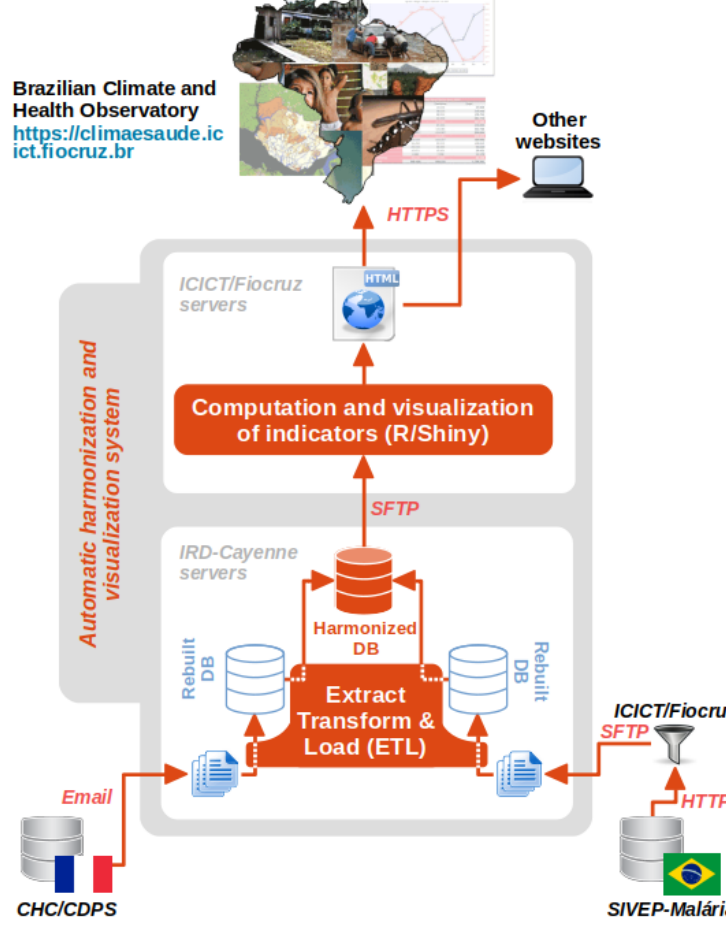
Figure 2. Overall system architecture and data and information flow. CDPS: Service des Centres Délocalisés de Prévention et de Soins (Department of the Centers for Prevention and Care); CHC: Centre Hospitalier de Cayenne (Cayenne Hospital); DB: database; Fiocruz: Fundação Oswaldo Cruz (Oswaldo Cruz Foundation); HTTPS: hypertext transfer protocol secure; ICICT: Instituto de Comunicação e Informação Científica e Tecnológica em Saúde (Institute of Scientific and Technological Communication and Information in Health); IRD: Institut de Recherche pour le Développement (French National Research Institute for Sustainable Development); SFTP: secure shell file transfer protocol; SIVEP-Malária: Sistema de Informações